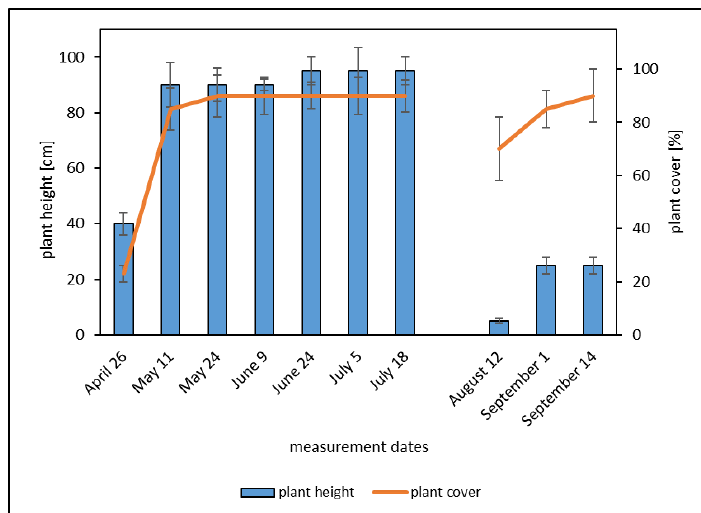
Figure 3. Vegetation development in the oilseed rape field.